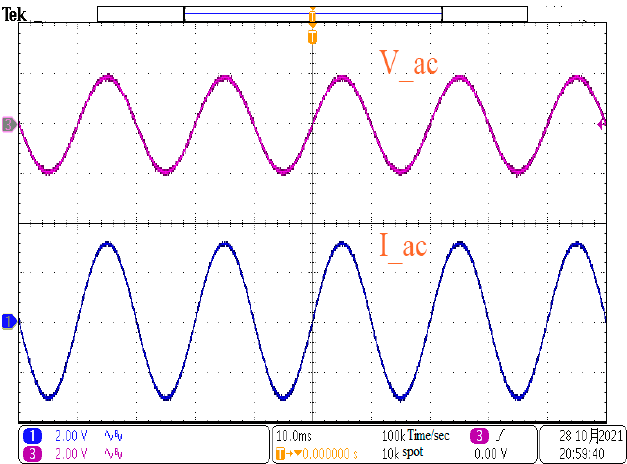
Figure 20. The battery’s current, voltage, and power under load and radiation changes.